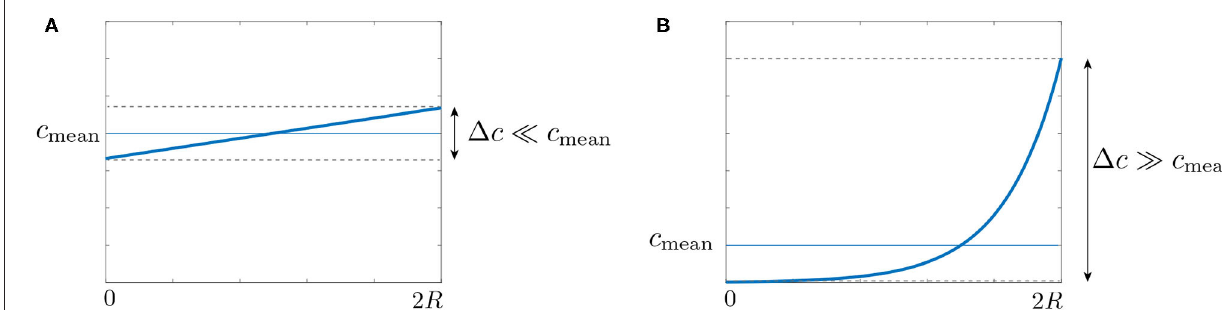
FIGURE 5 | Stationary auxin profile for (A) small and (B) large Peclet number.